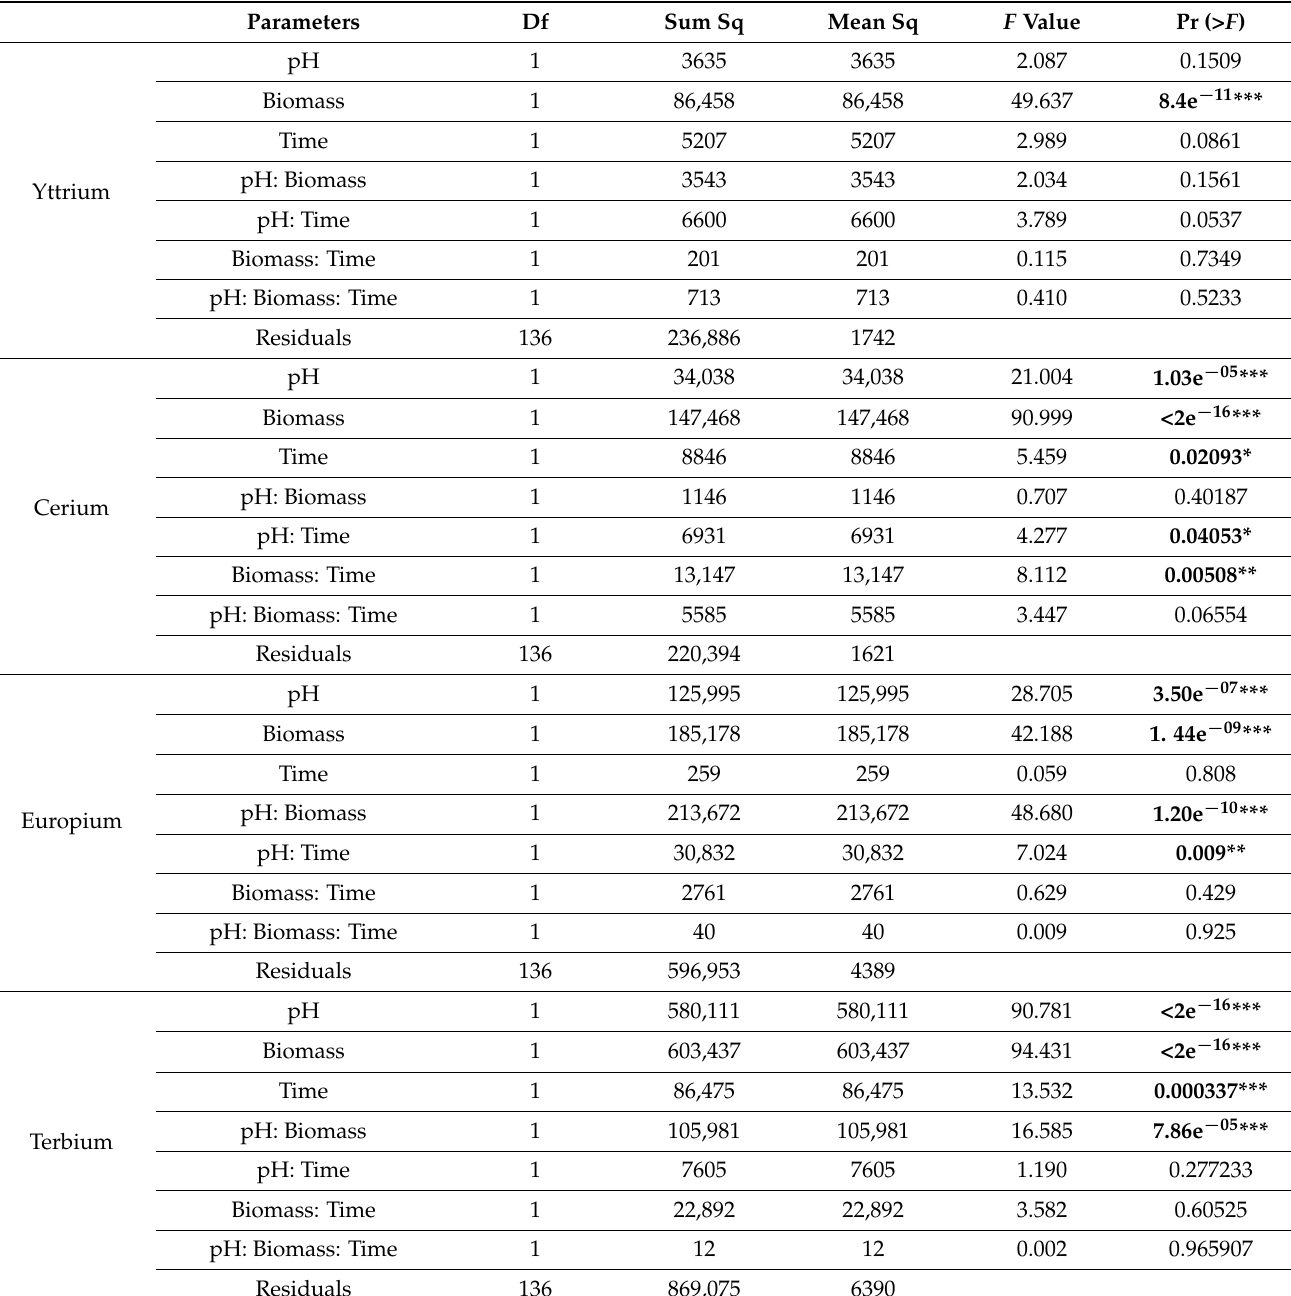
Table 2. Analysis of variance (two way-ANOVA), regression coefficient estimates and test of sig- nificance for adsorption capacity of freeze-dried G. sulphuraria for yttrium, cerium, europium, and terbium. *: level of significance; * p < 0.05; ** p < 0.01; *** p <